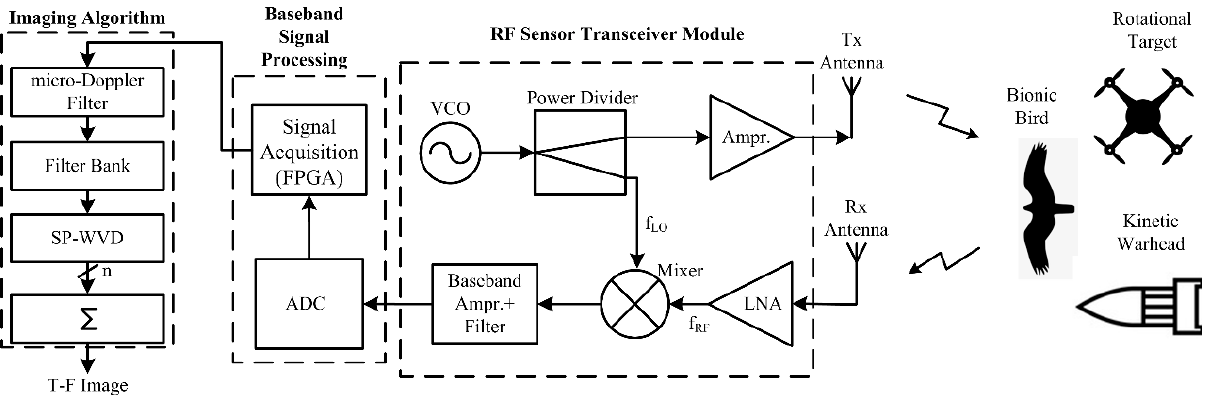
Figure 2. Photograph of the developed radio-frequency (RF) sensor’s experimental setup.